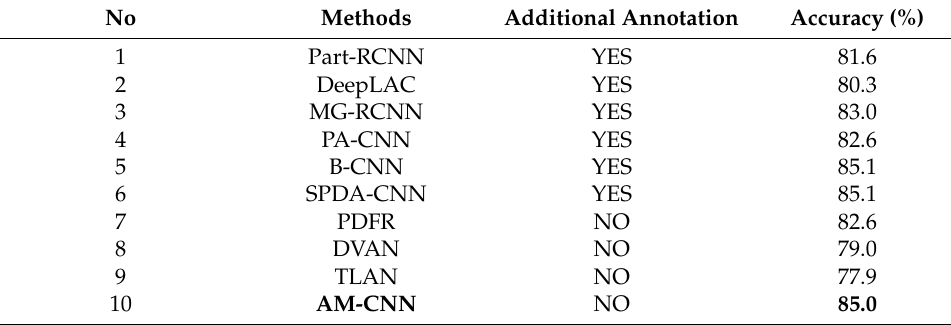
Table 3. Experimental results on the CUB200-2011